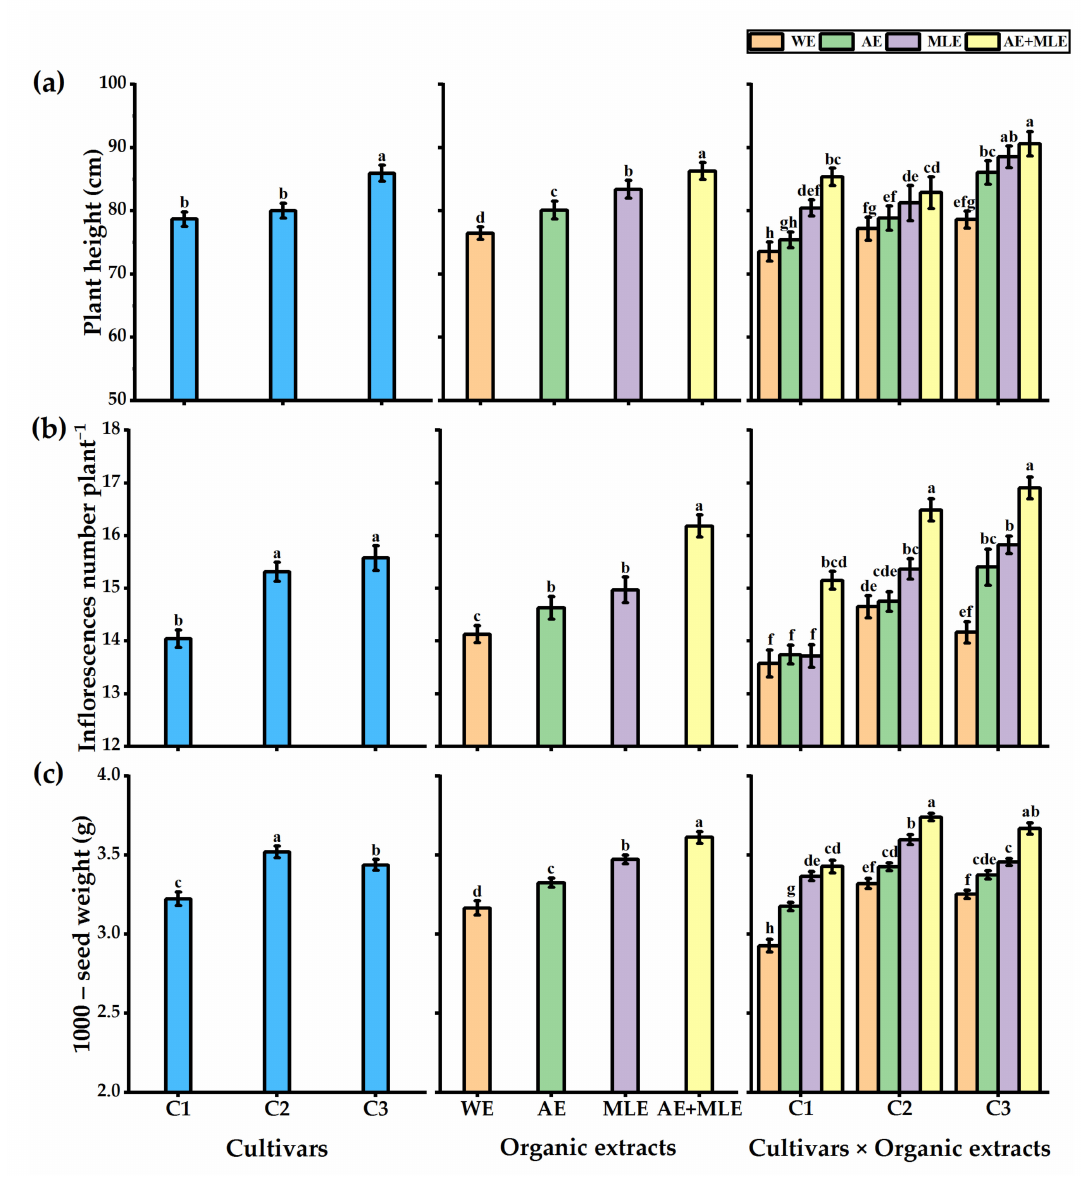
Figure 1. Effect of Azolla extract, moringa leaf extract, and their combination on ( a ) plant height (cm), ( b ) inflorescences number plant − 1 , and ( c ) 1000-seed weight (g) of three quinoa cultivars. C1 = KVL − SRAZ, C2 = Chipaya, C3 = Q − 37, WE = without extract, AE = Azolla extract, MLE = moringa leaf extract. Data are mean value ± SE, n = 3. Different letters denote significant differences at p ≤ 0.05